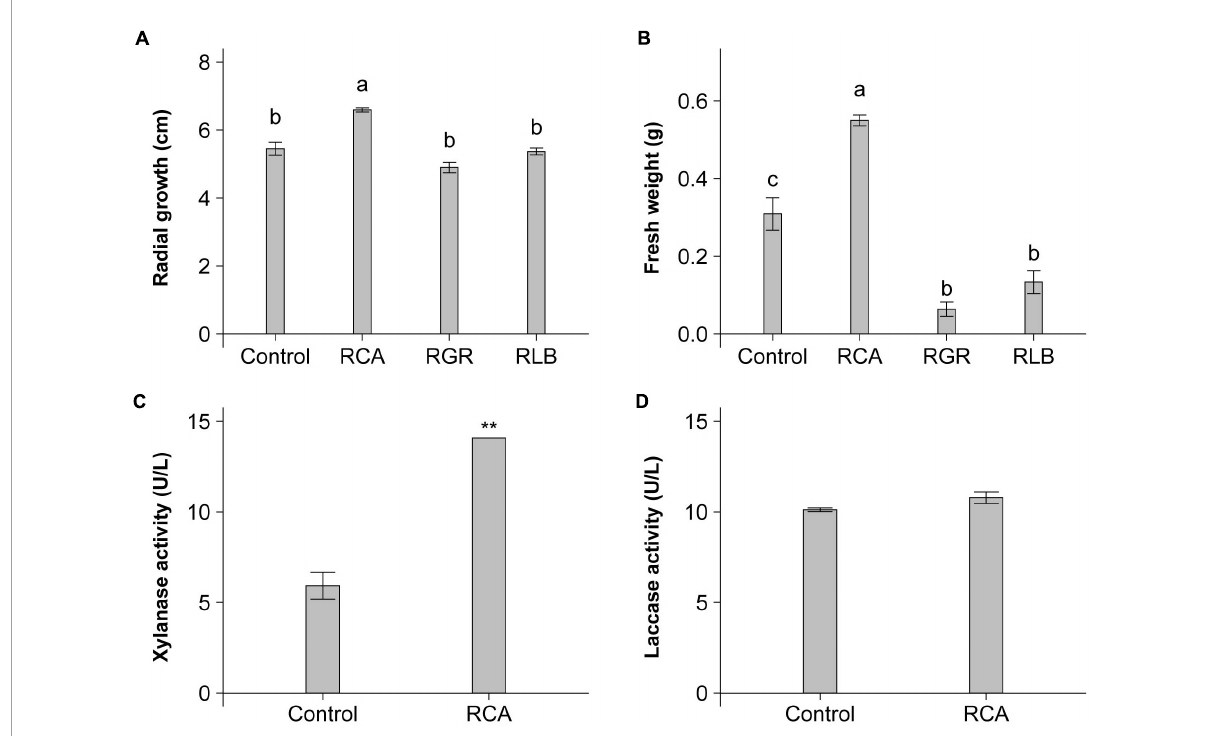
FIGURE3 Influence of bacterial inoculant on P. umbellatus and A. gallica . (A) Influence on mycelial growth rate of P. umbellatus , (B) influence on fresh weight of A. gallica , (C) influence on extracellular xylanase activity of A. gallica , and (D) influence on extracellular laccase activity of A. gallica. RCA, Rhizobium sp. CACMS001; RGR, R. grahamii CCGE 502 T ; RLB, R. leguminosarum bv. viciae USDA 2370 T . All data are presented as mean ± s.e. Bars with the same letter are not significantly different at the 5% LSD test. ** p < 0.01 between two groups, determined using two-sided Student’s t